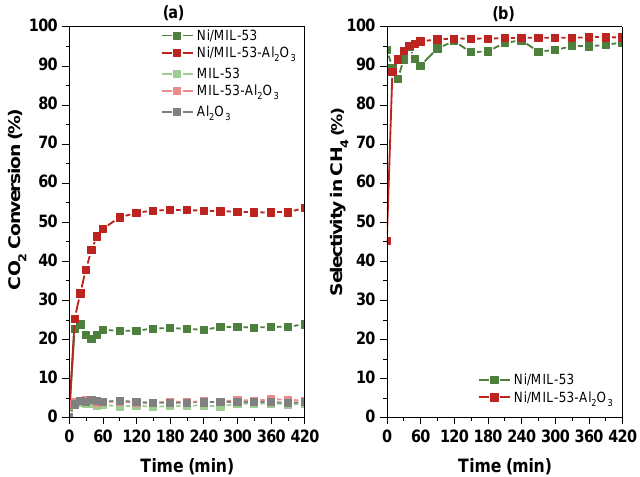
Figure 6. Stability of Ni/MIL-53 and Ni/MIL-53–Al 2 O 3 catalysts in the methanation of CO 2 at 280 °C: ( a ) conversion of CO 2 and ( b ) CH 4 selectivity (CO 2 :H 2 = 1:5.2; [CO 2 ] = 6.6%, p = 1 atm, 4650 h −1 ).